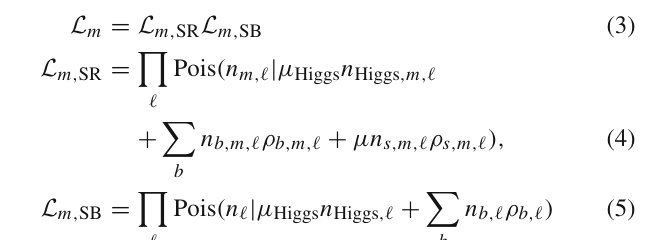
Fig. 2 Event yields against m Z with the ZX selection for the muon 2 andelectronchannels.Numbersinthelegendshowthetotaleventyields with the ZX selection corresponding to data, and the expected yields foreachbackgroundandsignalprocesses,alongwiththecorresponding statistical uncertainty coming from the amount of simulated